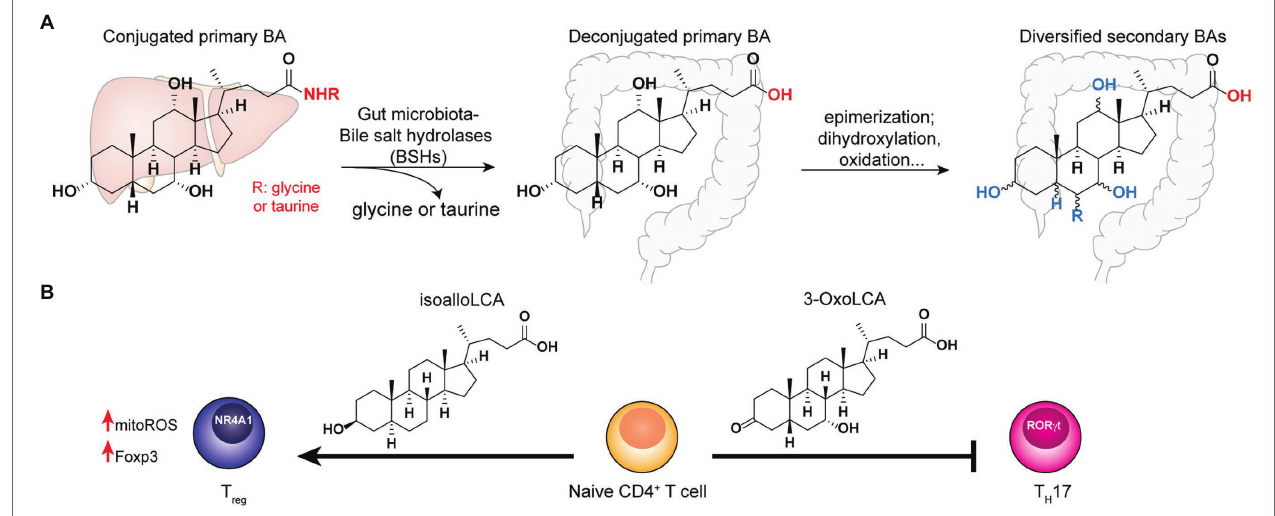
FIGURE 2 | Bile acids synthesized in the host liver undergo bile salt hydrolases (BSHs) reaction followed by diverse biotransformation by the gut microbiota to become a variety of secondary bile acid metabolites that play key functions in host homeostasis. (A) The co-metabolism of bile acid in host and gut microbiota. (B) The distinct effects of specific secondary bile acids to T-cell